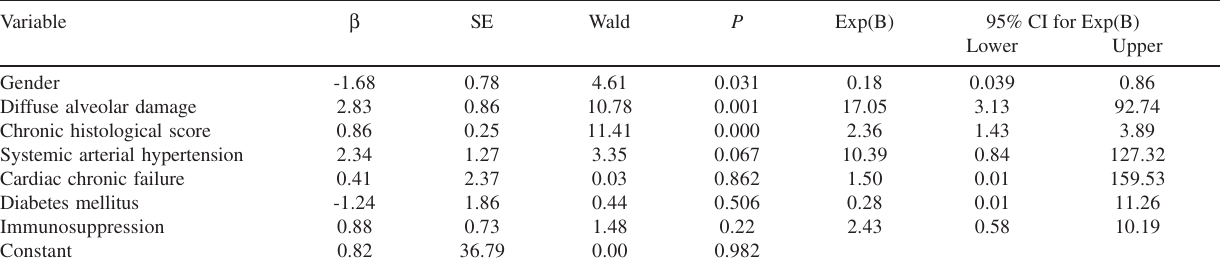
Table 3 - Evaluation of the risk of death using the scoring system on surgical lung biopsies by the multiple logistic regression model (chi-square = 32.9; P < 0.001)